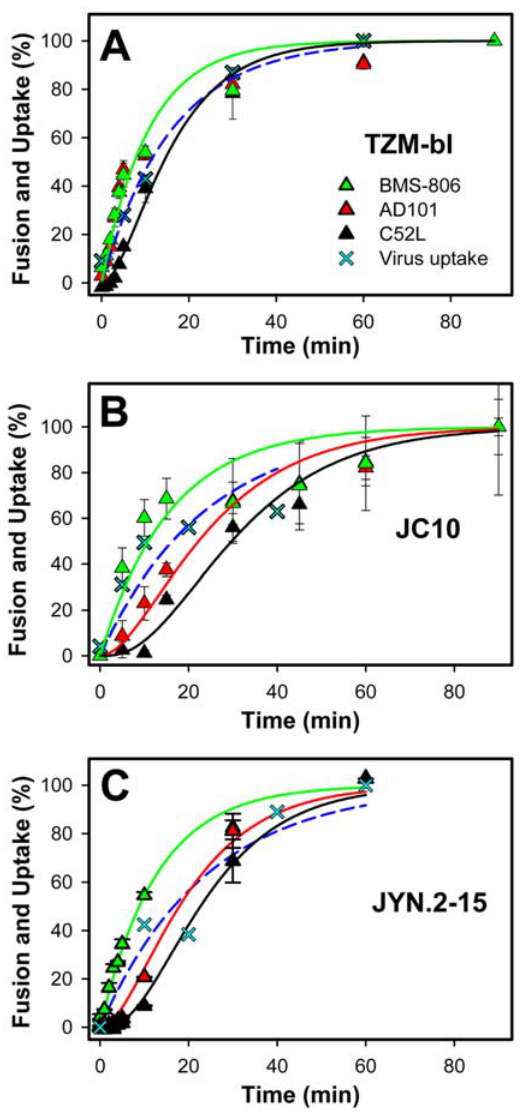
Figure 2. Kinetics of JRFL fusion with target cells expressing different levels of wild-type and mutant CCR5. (A) Fusion of JRFL pseudoviruses with TZM-bl cells was measured by adding inhibitors of distinct steps of this process (BMS-806, AD101 and C52L) at indicated time points, as described in the legend to Figure 1B. (B) JRFL fusion with HeLa-derived JC.10 cells expressing a low level of wild-type CCR5. (C) JRFL fusion with JYN.2-15 cells expressing a high level of mutant (Y14N) CCR5. Solid lines are the results of fitting the equations (10–12) of Appendix S1 to experimental data. The inactivation rate, k i , was determined by fitting a single-exponential function (dashed line) to the p24 uptake data (crosses). The k 1 was obtained by curve fitting the expression (10) for the probability of V CD4 to the rate of escape from BMS-806 (after entering the k i value and assigning arbitrary values to k 2 and k 3 ). The k i and k 1 were then used to obtain k 2 by fitting the equation (11) for V CD4CR to coreceptor binding data. Finally, these three rate constants were used to determine k 3 through curve-fitting the equation (12) for the probability of V E to the experimentally determined rate of virus escape from C52L. The lines are color-coded according to the symbols. Because the rates of JRFL escape from BMS-806 and AD101 were identical when TZM-bl cells were used as targets (panel A), only the CD4 binding curve (green line) is shown. Curve fitting was done using the SigmaPlot Regression Wizard (SYSTAT Software, Inc.).